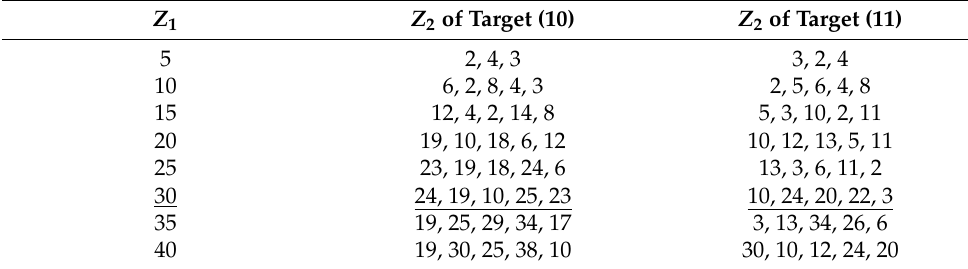
Table 7. Low-noise pole-slot numbers scheme for p =